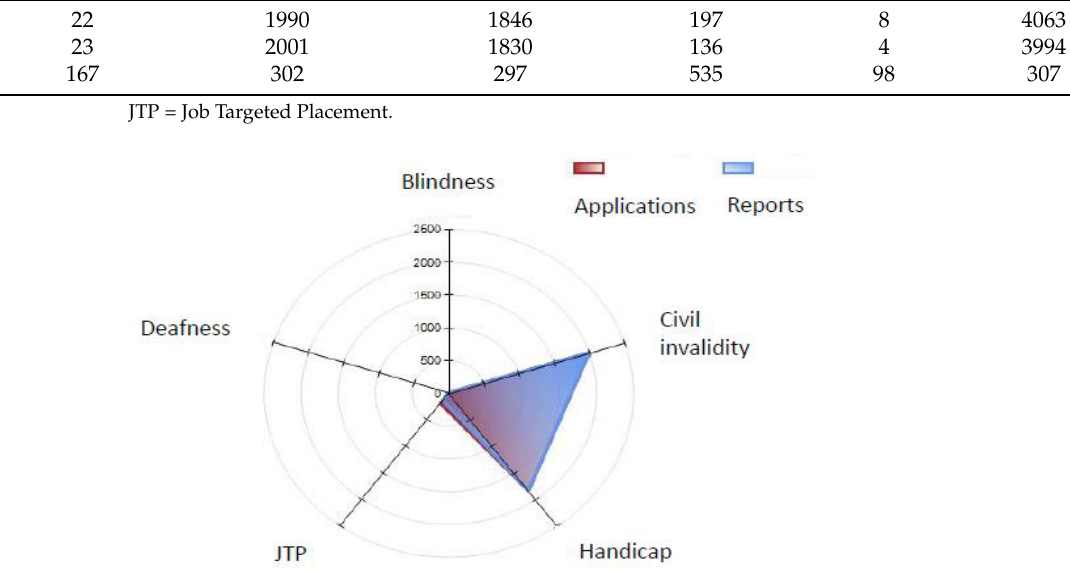
Figure 3. Iglesias: distribution of total applications and ASL reports for 2021